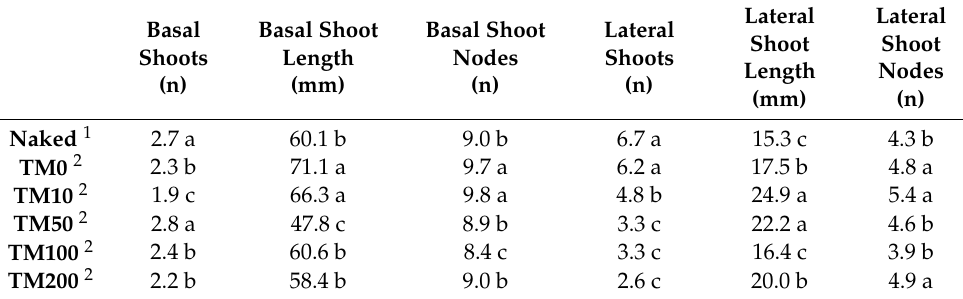
Basal Shoot Length (mm)